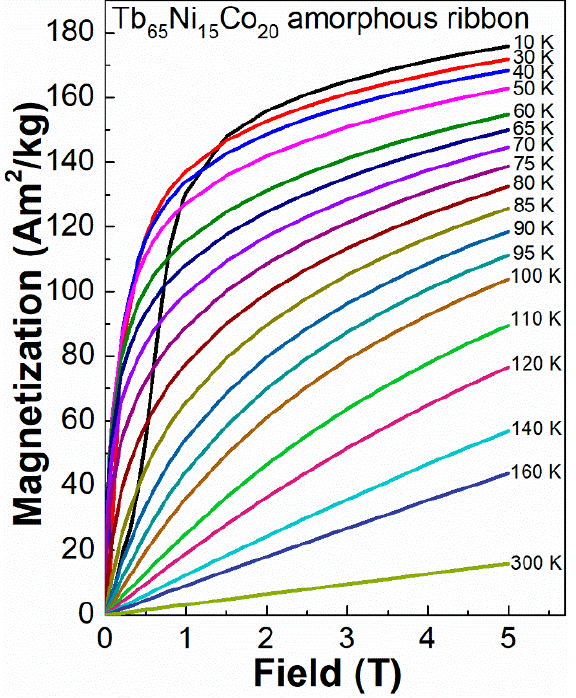
Figure 4. The isothermal M - H curves of the Tb 65 Ni 15 Co 20 amorphous ribbon measured at various temperatures under a magnetic field of 5 T.